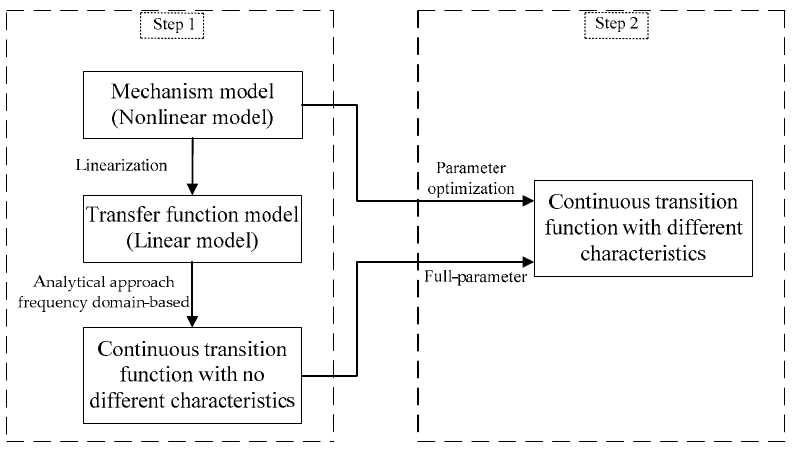
Figure 2. Diagram of the TSO-FD.